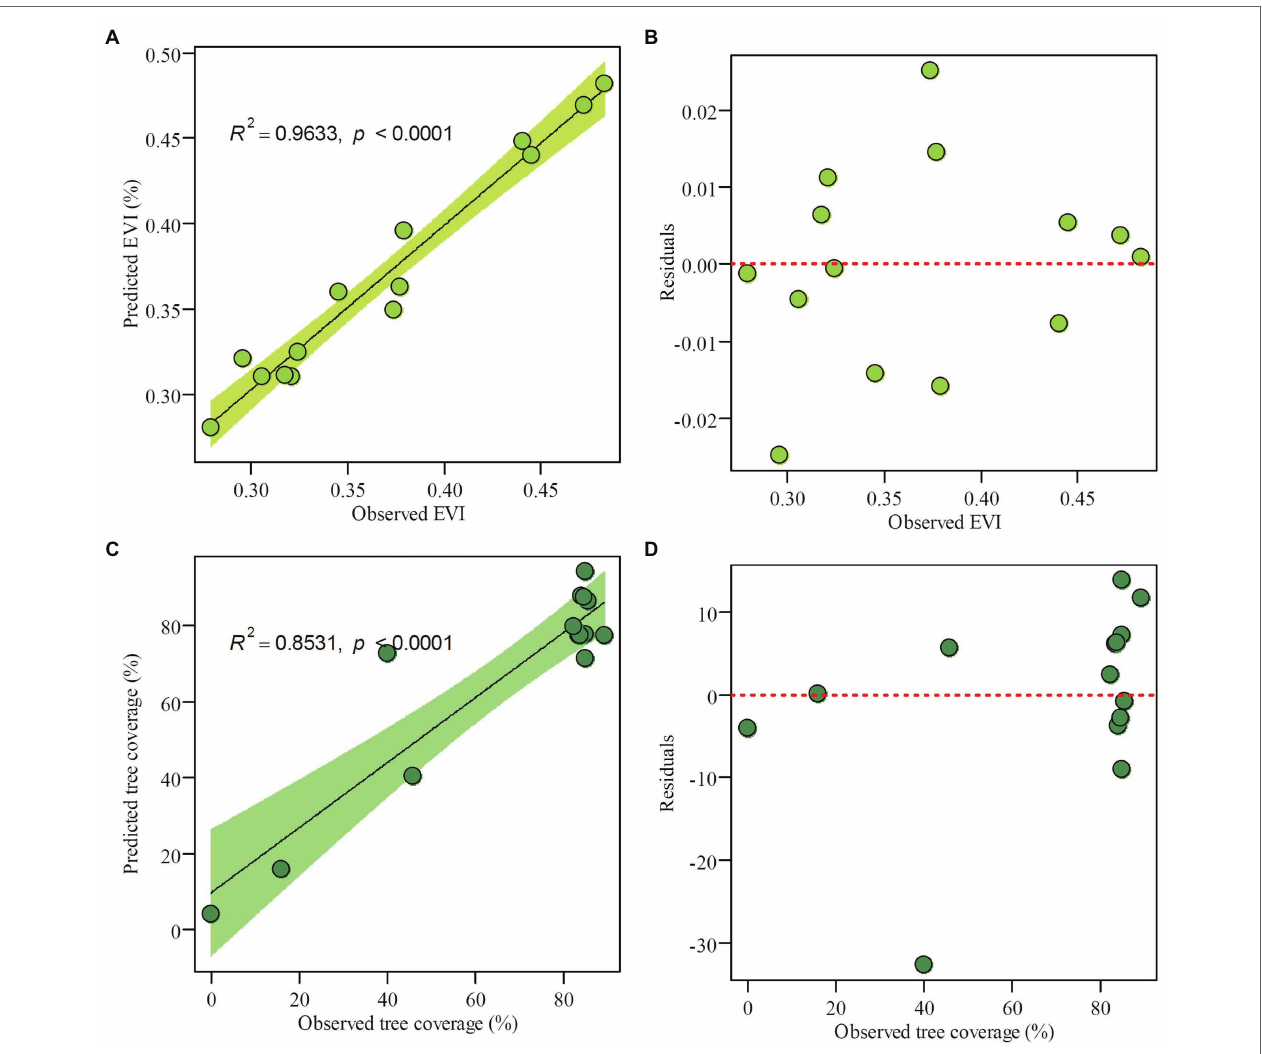
FIGURE 6 | The 5-component WA-PLS inference model results for (A) observed versus predicted enhanced vegetation index (EVI), (B) observed EVI versus residual values, (C) observed versus inferred tree coverage (%), and (D) observed tree coverage versus residual